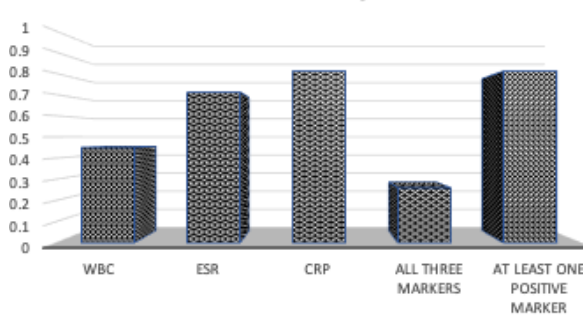
Figure 2. Sensitivity for true abscess when either WBC, ESR, CRP, all three markers, or at least one marker were positive. In order, the sensitivities were 0.45, 0.71, 0.81, 0.26, and 0.81.